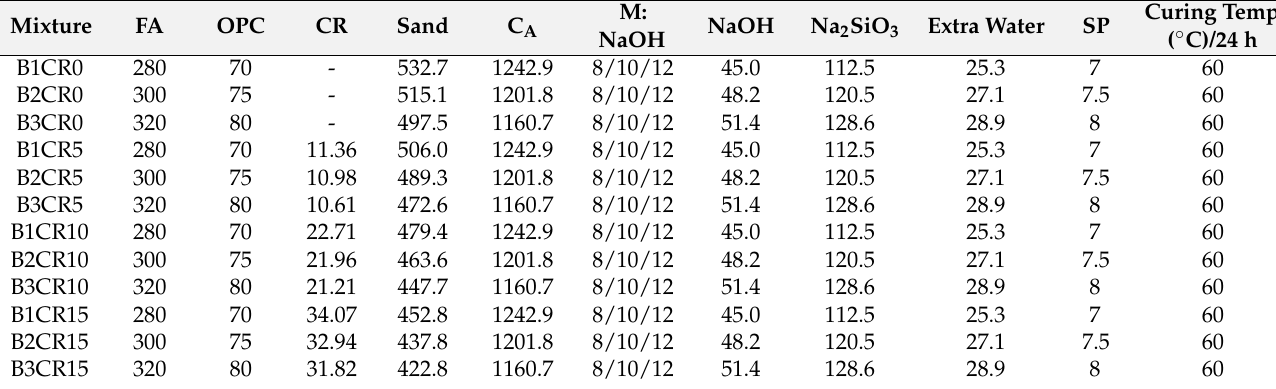
Table 5. Mix proportions used in this study (by weight).